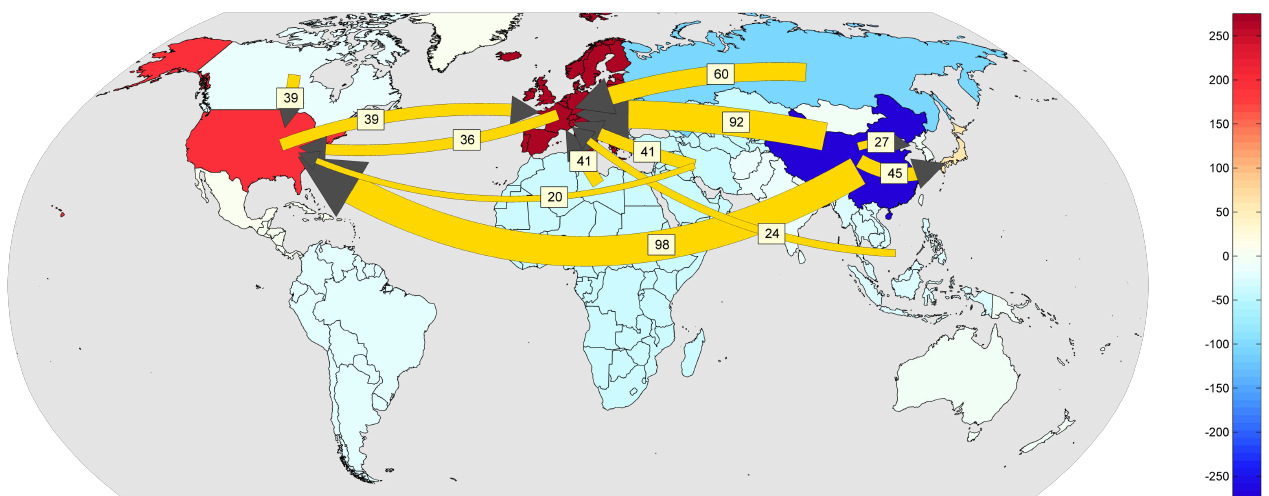
Fig. 8. The 12 largest inter-regional flows of carbon embodied in trade, from origin of emissions to the region of final consumption, with key regions disaggregated (2004). The largest single inter-regional flow is from China to USA (98MtC). These 12 flows account for 40% of all inter-regional flows using this